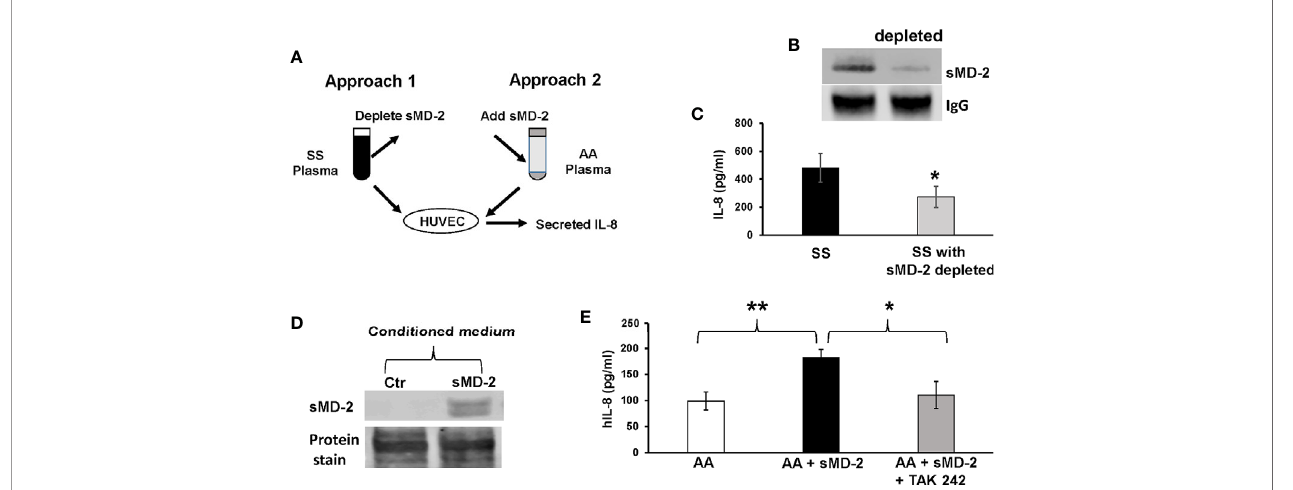
FIGURE 3 | sMD-2 in plasma mediates IL-8 secretion by HUVEC. (A) Diagram shows two approaches to study sMD-2 ’ s contribution to HUVEC IL-8 secretion. In approach 1, sMD-2 is depleted from SS plasma and in approach 2, sMD-2 is added to AA plasma. Plasma (2%) from both approaches were incubated with HUVEC for 18 hours and IL-8 secretion into the media was measured by ELISA. (B) Representative western blot of SS plasma after sMD-2 depletion. The IgG western blot was shown as loading controls. (C) IL-8 secretion by HUVEC after incubation with MD-2-depleted SS plasma. (D) Western blot of recombinant sMD-2 in conditioned medium from CHO cells transfected with MD-2-containing plasmids or non-transfected control CHO media. The total protein stain was shown as loading controls (E) sMD-2 CHO-conditioned medium or control CHO medium (10%) were added to HUVEC culture media along with 2% AA plasma in the presence or absence of TLR4 inhibitor, TAK-242 (1 µM), and incubated with HUVEC for 18 hours. The secreted IL-8 was measured by ELISA. Bars in C and E are means ± SD (n=3). * p <0.05, ** p